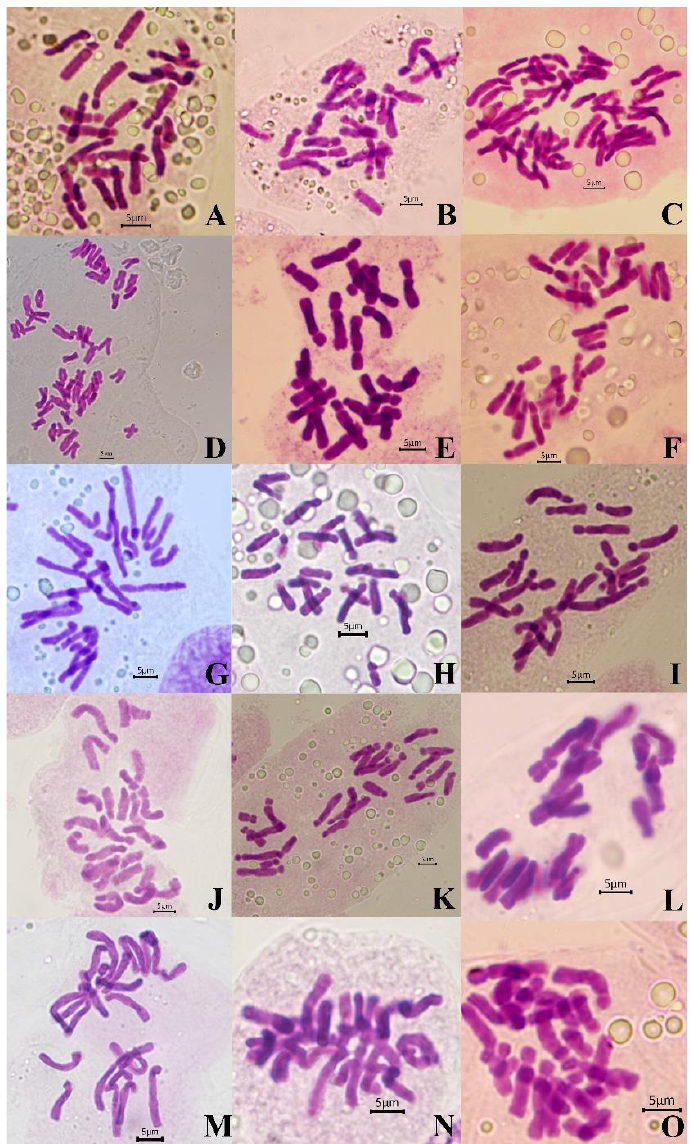
Figure 1. Chromosome numbers of Amana . ( A ) A. edulis (2 n = 2 x = 24, WMZ1408); ( B ) A. edulis (2 n = 2 x = 24, WMZ1486); ( C ) A. edulis (2 n = 4 x = 48, WMZ1494); ( D ) A. edulis (2 n = 4 x = 48, Daejeon, South Korea); ( E ) A. tianmuensis (2 n = 2 x = 24, WMZ1504); ( F ) A. tianmuensis (2 n = 3 x = 36, WMZ1502); ( G ) A. nanyueensis (2 n = 2 x = 24, WMZ1464); ( H ) A. anhuiensis (2 n = 2 x = 24, WMZ1480); ( I ) A. baohuaensis (2 n = 2 x = 24, WMZ1407); ( J ) A. wanzhensis (2 n = 2 x = 24, WMZ1460); ( K ) A. erythronioides (2 n = 2 x = 24, WMZ1435); ( L ) A. kuocangshanica (2 n = 2 x = 24, WMZ1443); ( M ) A. latifolia (2 n = 2 x = 24, WMZ1445); ( N ) Amana sp.1 (2 n = 2 x = 24, WMZ1458); ( O ) Amana sp. 2 (2 n = 2 x = 24,